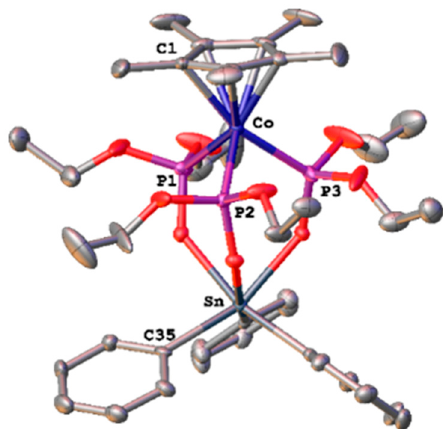
Figure 4. The molecular structure of 3b in the solid state. Thermal ellipsoids are set at 50% proba- bility. Hydrogen atoms are omitted for clarity. Hydrogen atoms are omitted for